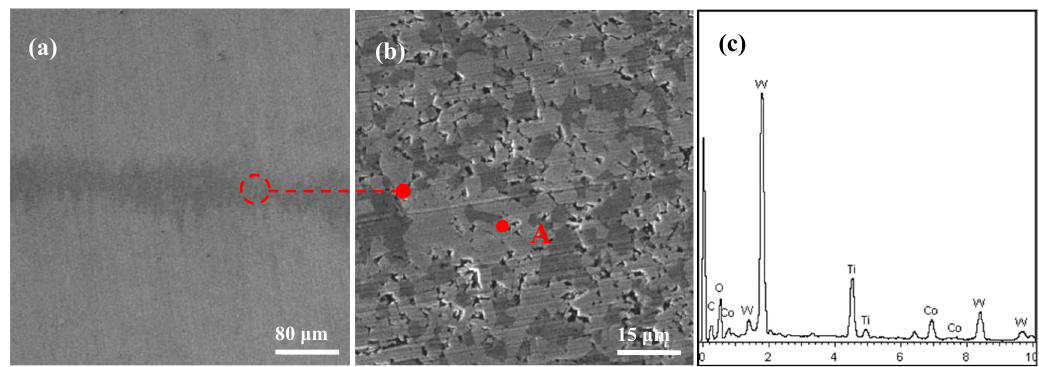
Figure 6. SEM micrographs of the worn surface of the conventional SC2 sample after 15 min sliding friction at the speed of 7 mm/s and load of 50 N: ( a ) SEM micrograph of the wear scar; ( b ) enlarge micrograph corresponding to ( a ); ( c ) EDX composition analysis of point A in ( b ).